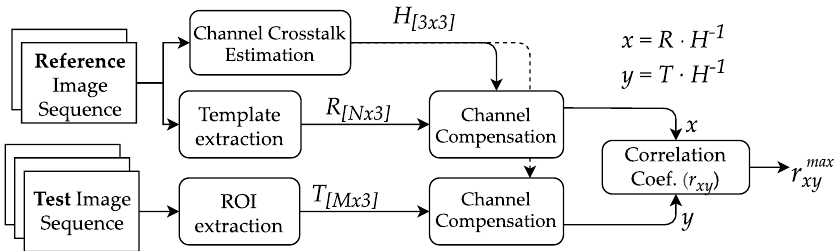
Figure 2. Flow diagram of the offline processing of data captured by cameras.